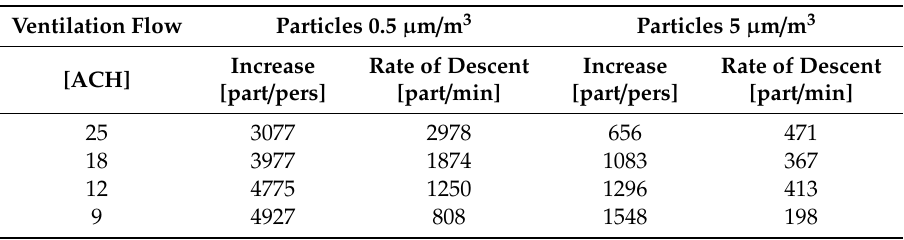
Table 4. Parameters calculated using experimental